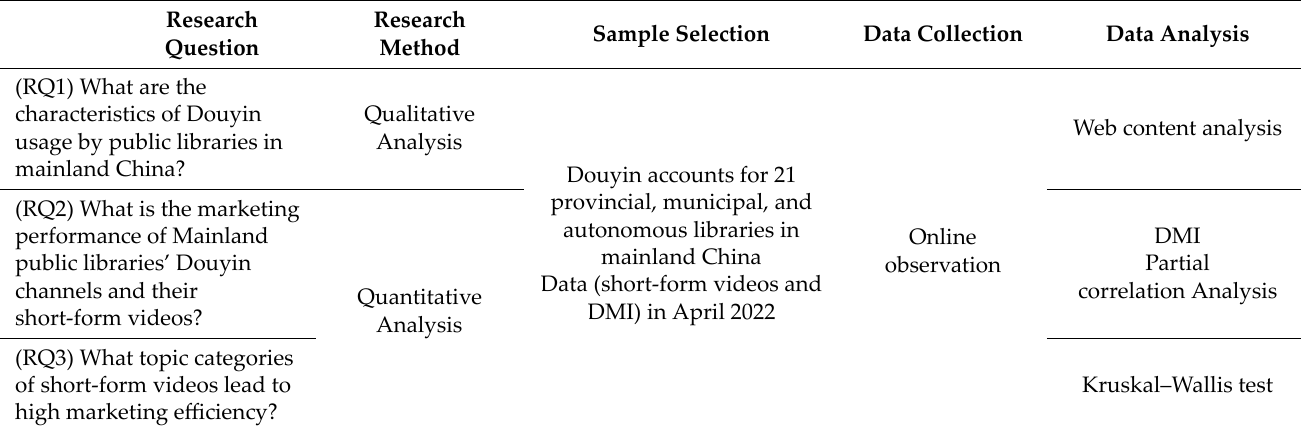
Table 2. Research